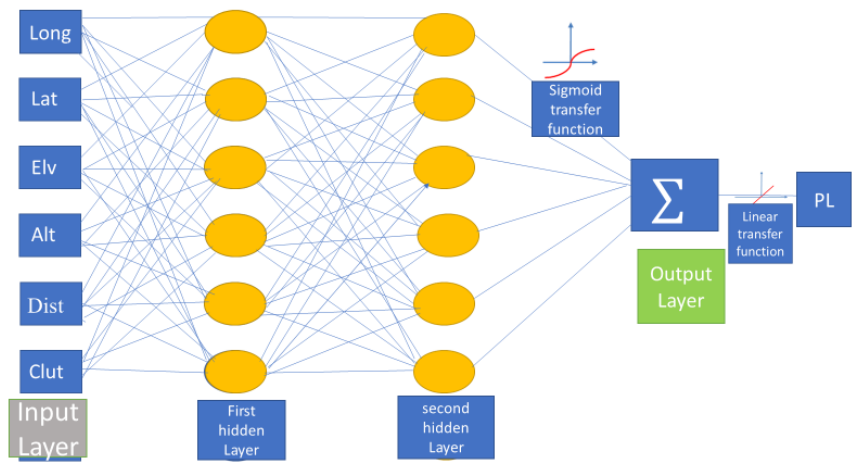
Figure 2. MLP network architecture (with two hidden layers) for Dataset 2.